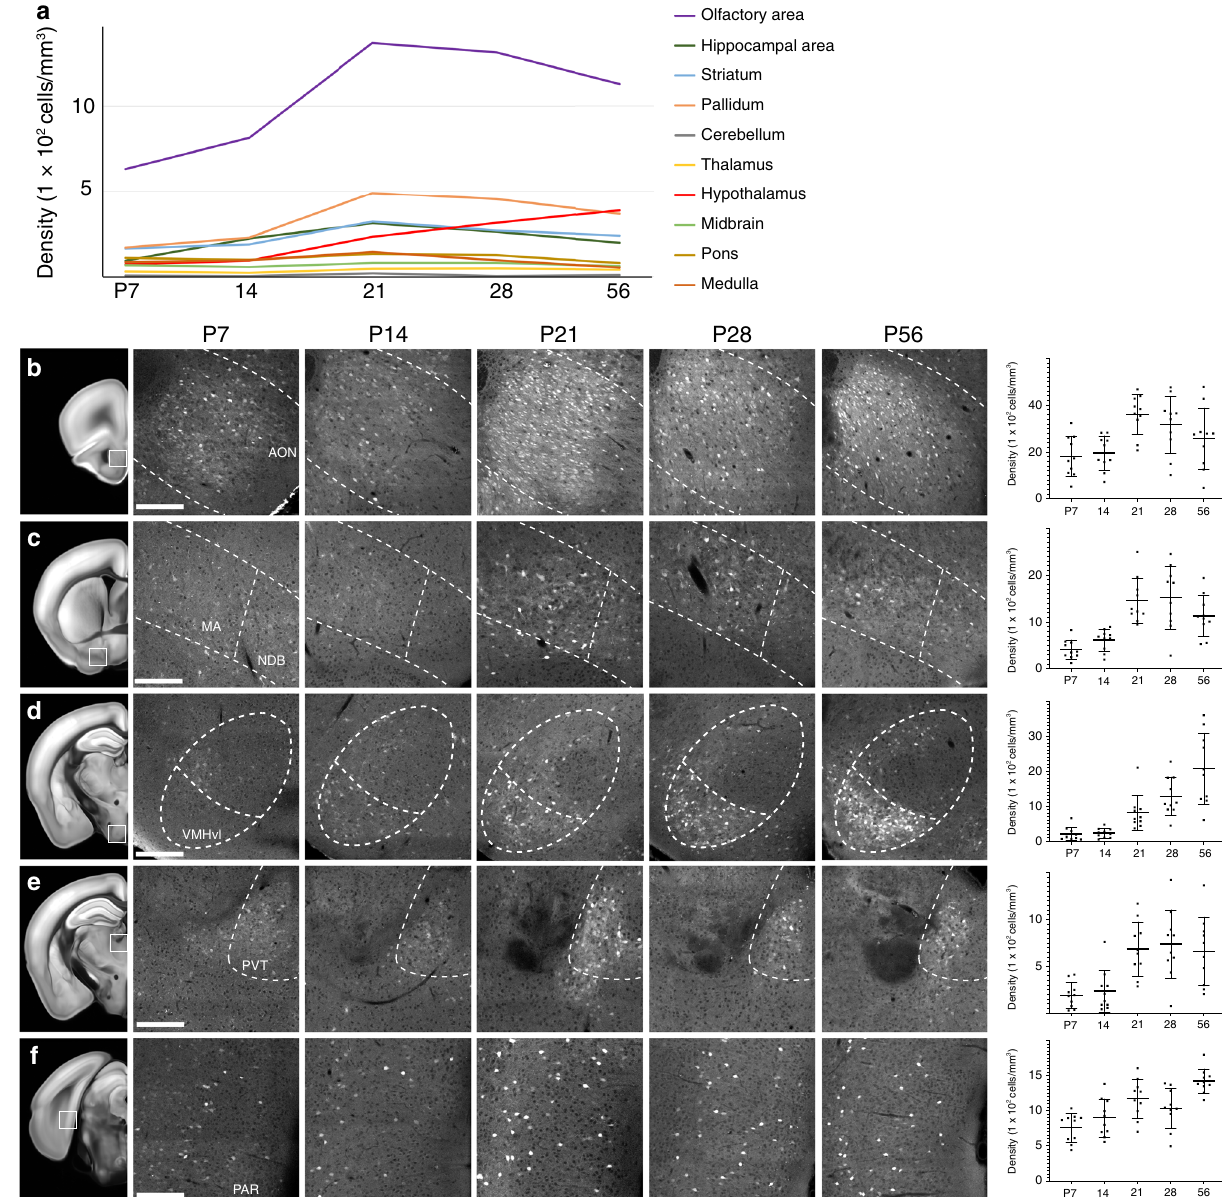
Fig. 6 Temporal expression patterns in other cortical and subcortical regions. a Average density of OTR neurons in ten different major subregions of the brain at postnatal development periods. b – f Notable brain regions with different temporal expression patterns. The fi rst column highlights anatomical region of interest with white boxes in the adult reference brain. Mid columns represent zoomed-in picture of highlighted brain regions at different ages between P7 – P56. Scale bar = 200 µ m. The last column is for the OTR ( + ) cell density measurement of the selected region (error bar = mean ± standard deviation). b The anterior olfactory nucleus (AON). c The magnocellular regions (MA) and the nucleus of diagonal band (NDB) in the basal forebrain area. d The ventral medial hypothalamus ventral medial (VMHvl) in hypothalamic areas. e The paraventricular thalamus (PVT) in thalamus. f The parasubiculum (PAR) as a part of the retrohippocampal